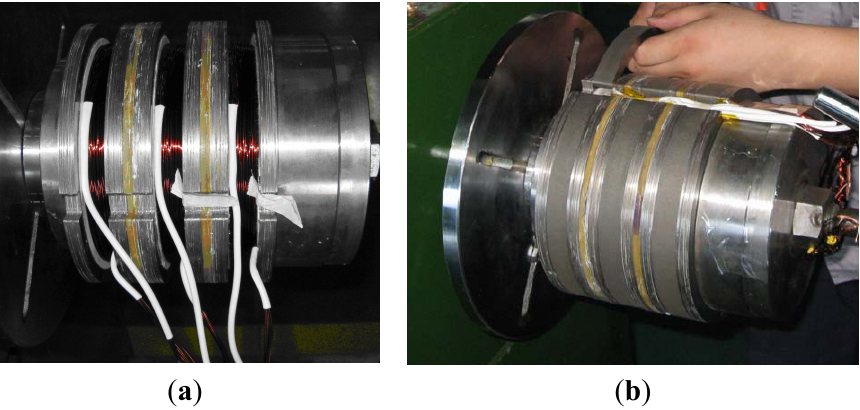
Figure 10. Manufacturing process of the 3-phase stator. ( a ) winding coils between the stator teeth; ( b ) installing the stator yoke.